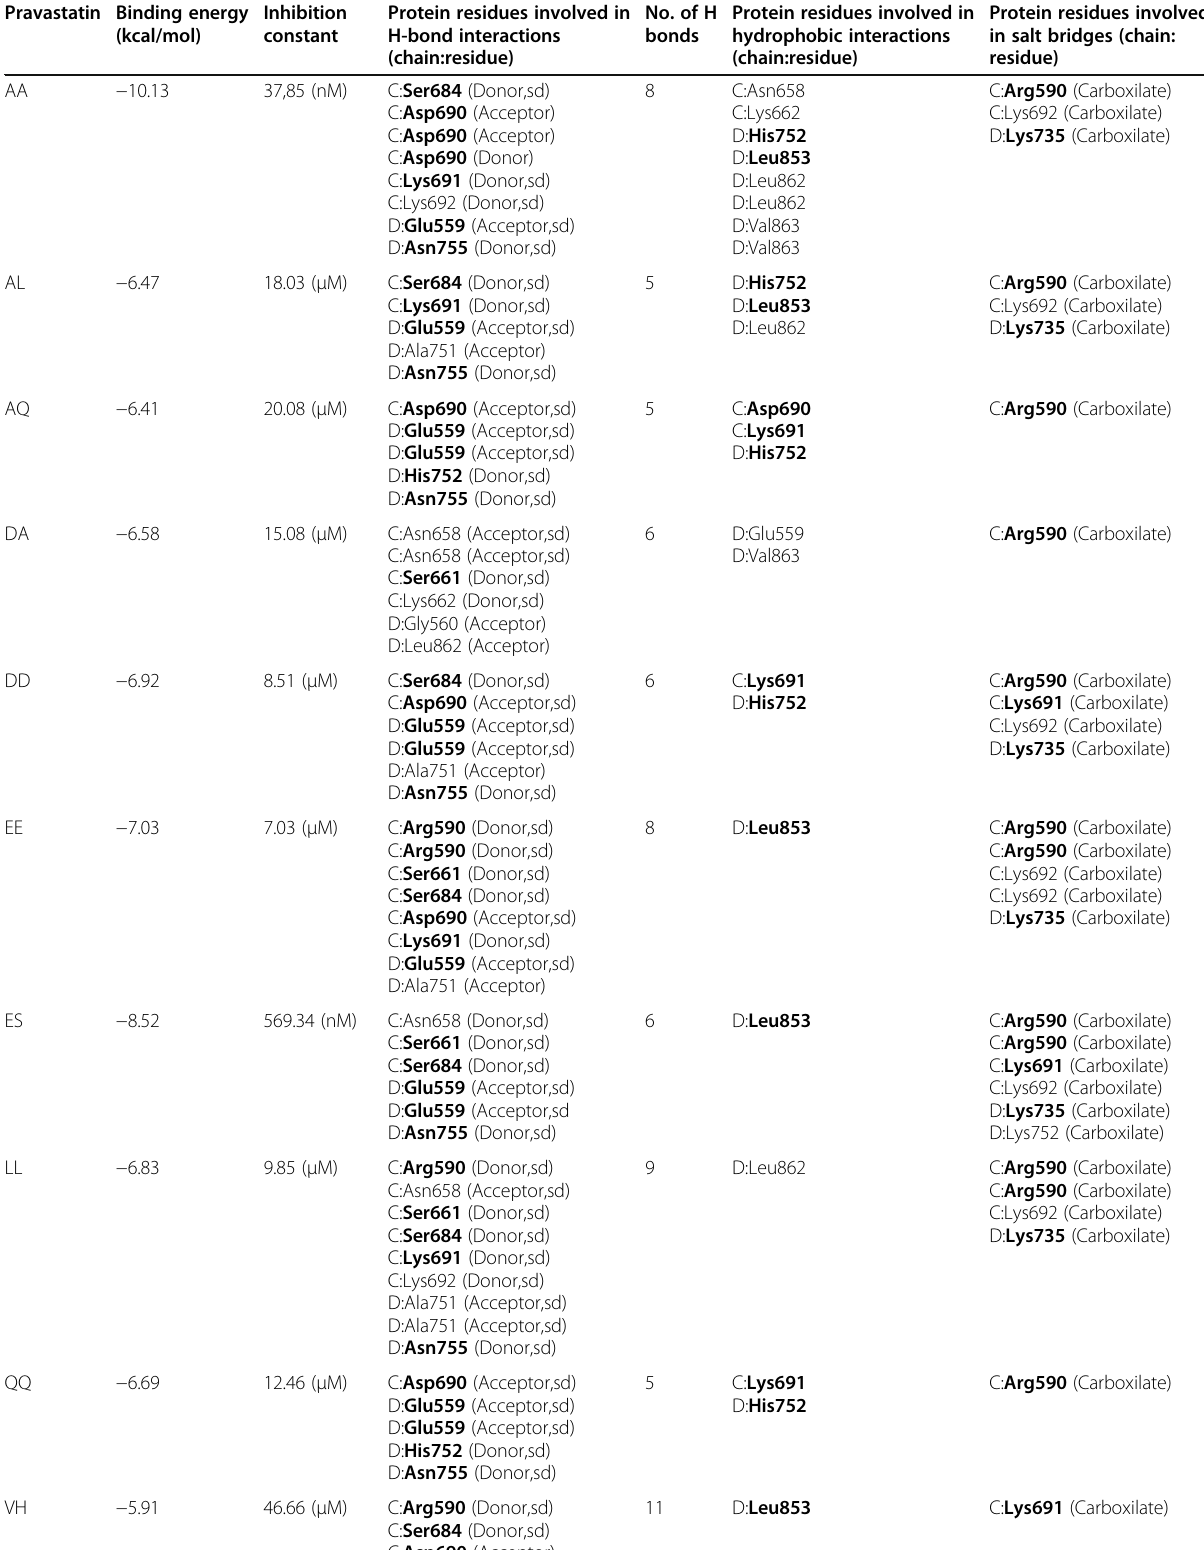
Table 4 HMG-CoAR binding site residues involved in docking interactions with pravastatin and dipeptides, with docking scores Pravastatin Binding energy